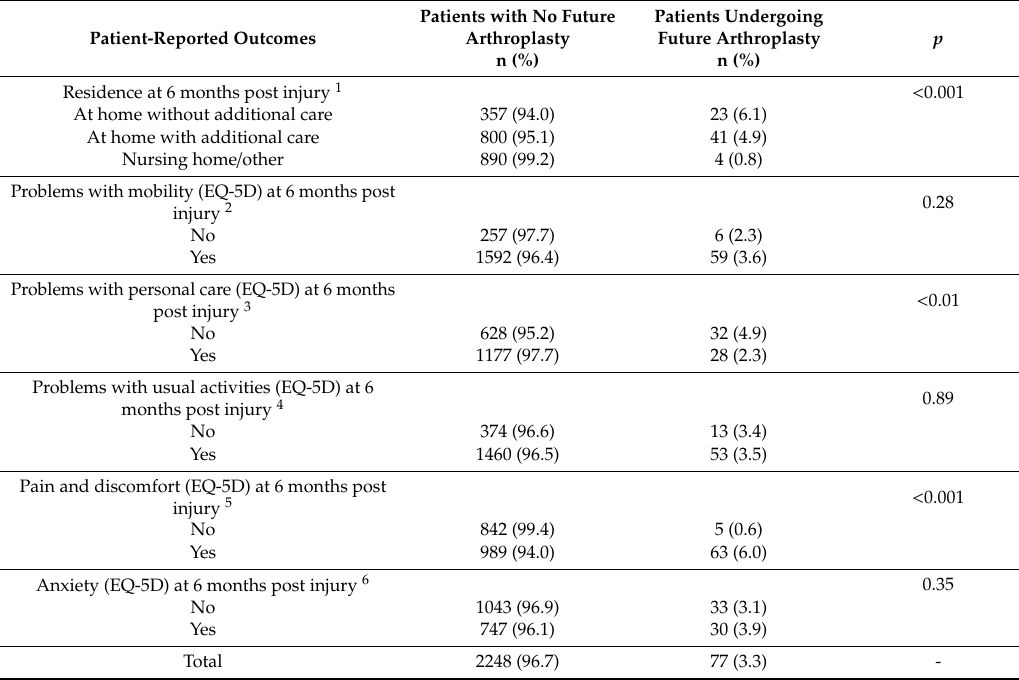
Table 2. Six-month patient-reported outcome measures associated with future revision arthroplasty or conversion to arthroplasty (n =